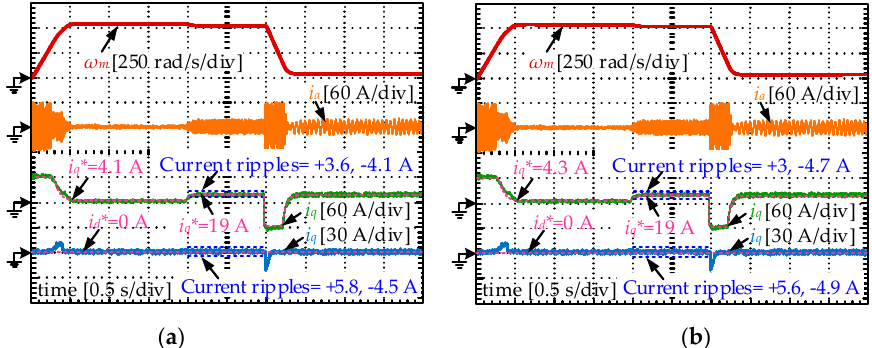
Figure 14. Experimental results of the traditional FCS-MPCC method under different resistance and inductance disturbances: ( a ) L 0 = 0.5 L , ∆ L = 0.5 L , R s0 = 0.5 R s , ∆ R s = 0.5 R s ; ( b ) L 0 = 2 L , ∆ L = − L , R s0 = 5 R s , ∆ R s = − 4 R s .